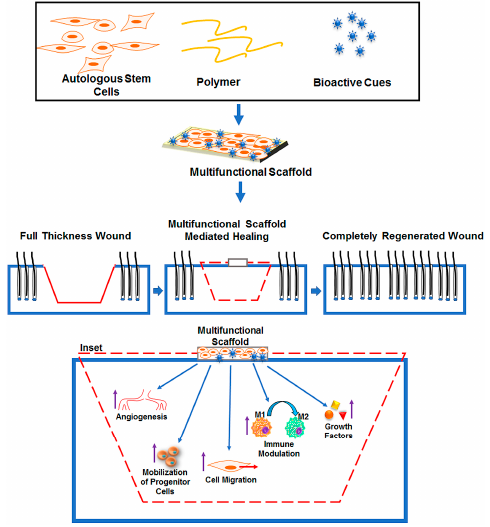
Figure 1. Schematic showing development of a personalized regenerative treatment modality for chronic wound patients by fabricating a multifunctional scaffold system using autologous stem cells, different bioactive cues, and polymer of interest. The scaffold when implanted into a full thickness wound would promote regenerative healing (scar-free) by providing a vascular bed, modulating inflammatory M1 macrophages to a pro-healing M2 macrophages, inducing movement of progenitor cells and increased migration of fibroblast and keratinocytes.